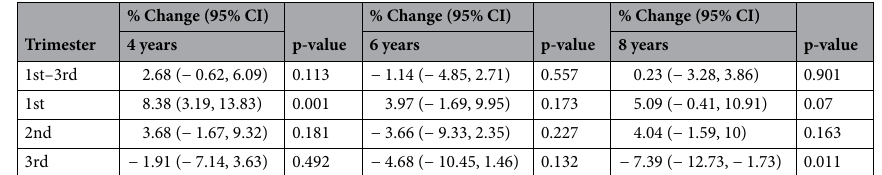
Table 2. Prenatal SO 2 exposure and ADHD rating scale at 4, 6 and 8 years of age in the cohort (n = 329). Adjusted for maternal age at pregnancy, mother’s education levels, maternal smoking, maternal environmental tobacco smoking, season of child’s birth.